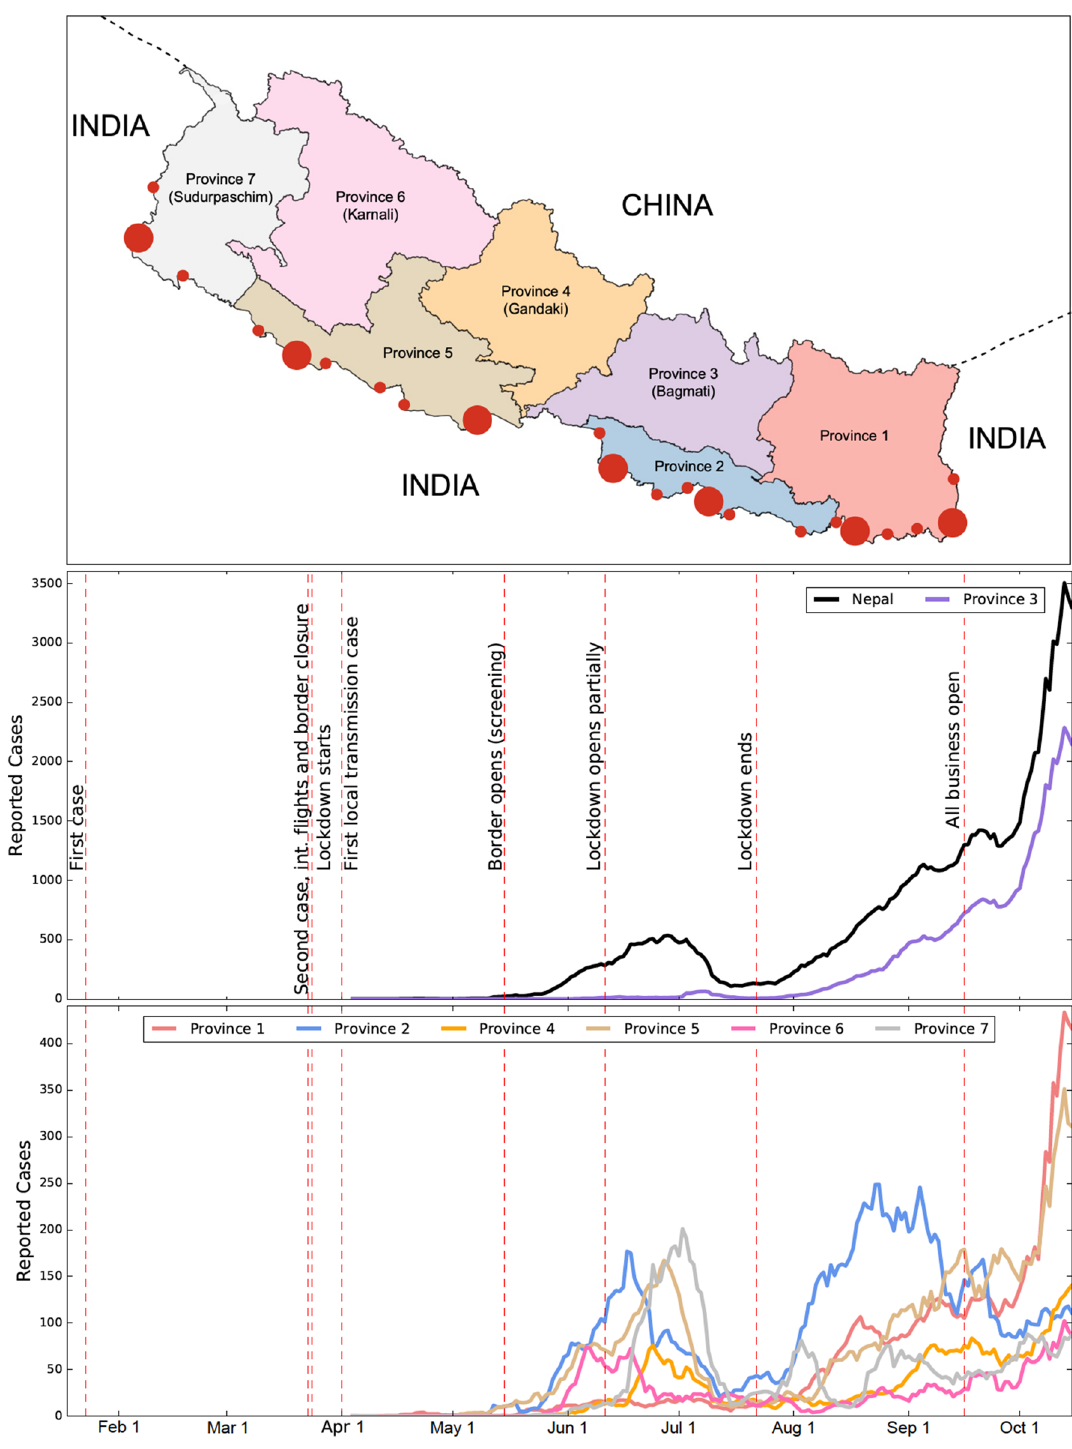
Figure 1. (Top Panel) A map of Nepal showing its seven provinces and entry-points (filled red circles) along the border with India. To create the map, the data (shapefile format) was obtained from the official webpage (http:// dos. gov. np) of the government of Nepal (Accessed on April 23, 2021) 45 . The map was then created using GeoPandas Verson 0.8.1 (https:// geopa ndas. org/ index. html) 45 module in Python programming. The large-sized circles indicate the major entry points: Kanchanpur, Nepalganj, Siddharthanagar, Birgunj, Jaleshwar, Biratnagar, and Kakarbhitta (listed from the left to right). The small-sized circles indicate the minor entry points (official border crossings) 46 . (Middle and Bottom Panels) The number of reported cases of COVID-19 in Nepal and in its provinces from January 23, 2020 to October 15, 2020. Because of the high magnitude of the cases of Province 3, the daily new cases data are shown in the same graph (middle panel) for Province 3 and the whole country, while the daily new cases data for the remaining six provinces are shown together in a single graph (bottom panel). The vertical red dashed lines represent the dates corresponding to the policy changes by the